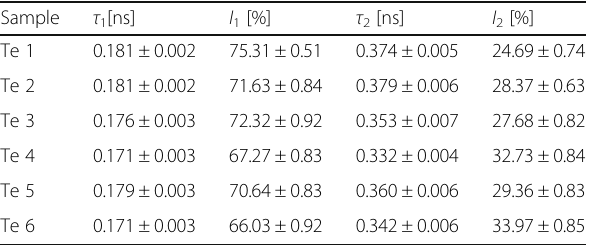
Table 2 Fitting parameters of tellurite glasses mathematically treated with two-component fitting procedure by LT computer program Sample